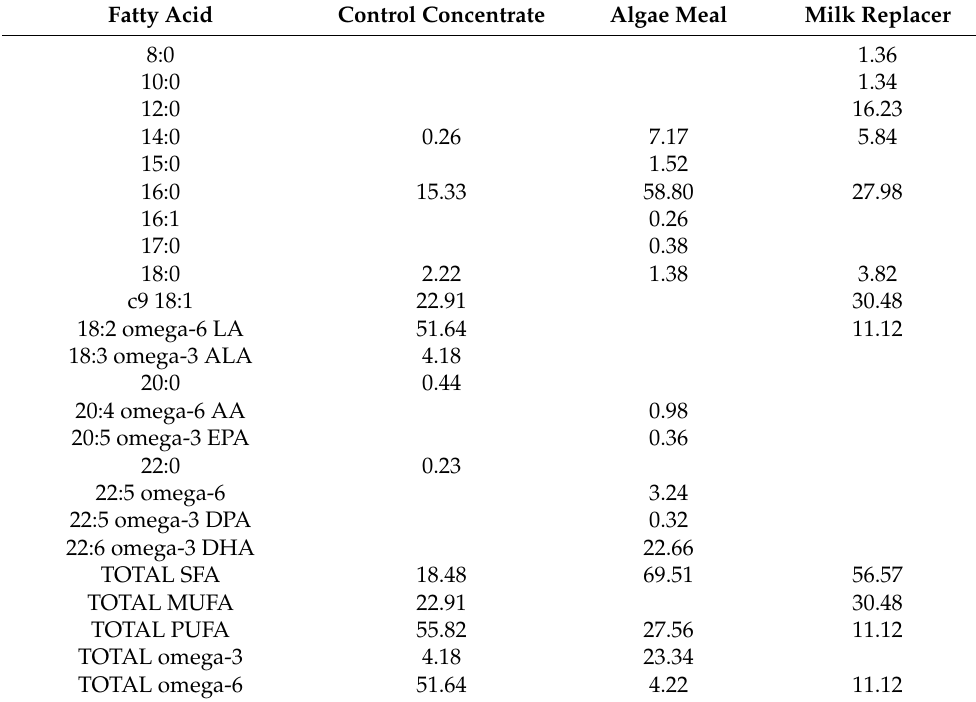
Table 1. Fatty acid composition of the feeds used in the experimental treatments (g/100 g of total fatty acid methyl